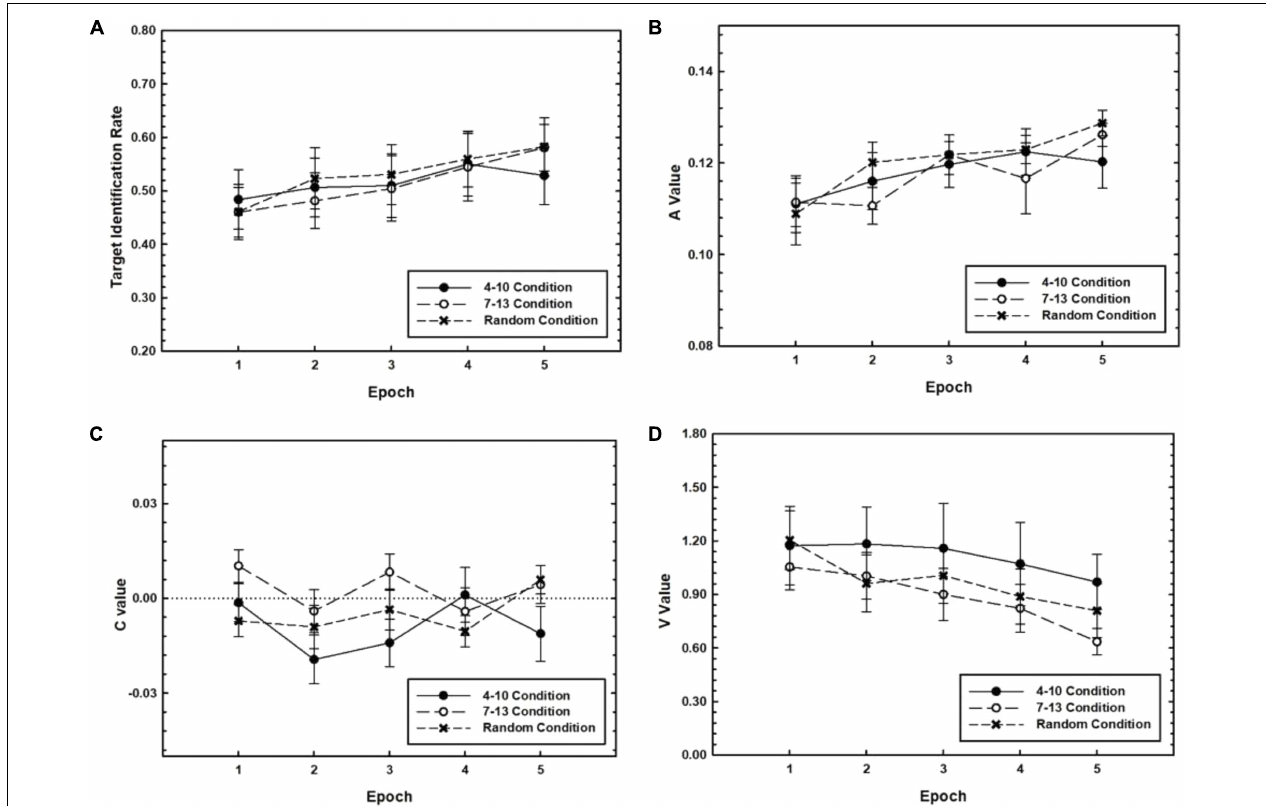
FIGURE 2 | Target identification rate (A) , A values (B) , C values (C) , and V values (D) for RSVP performance during the training phase for the 3-Day group plotted as a function of Training Epoch. Separate plots are shown for the 4–10, 7–13, and random Target Timing conditions. Error bars represent the SEM.